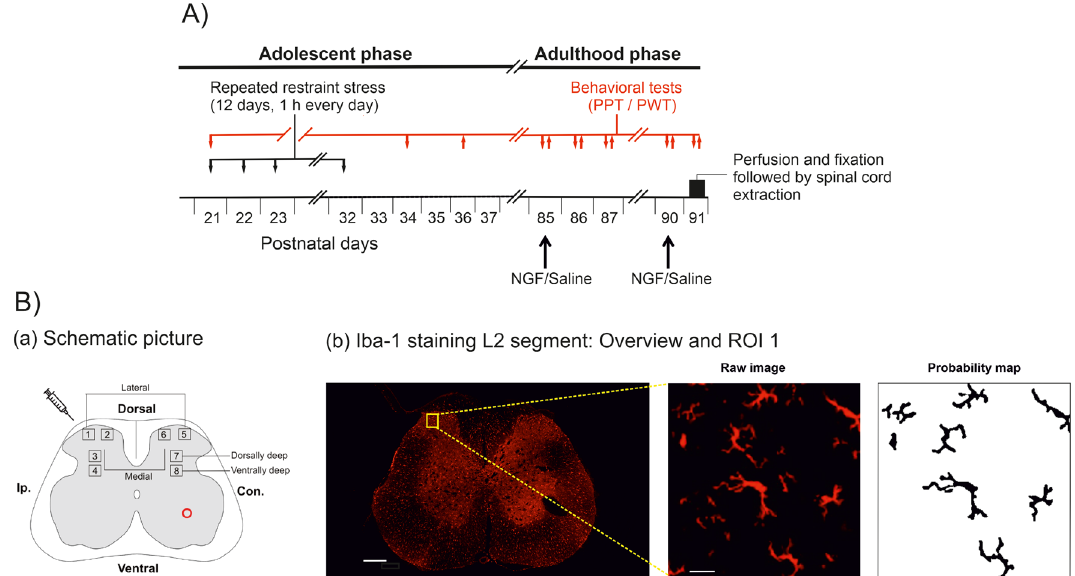
Figure 1. Experimental procedure. ( A ) Animals of the stress group were repeatedly stressed (black line) in a narrow plastic restrainer for 12 consecutive days for 1 h every day on postnatal days (PD21-32; early adolescent phase; black line). The pressure pain threshold (PPT) of the left multifidus muscle at vertebral level L5 and paw withdrawal threshold (PWT) of the left hind paw was measured at different time points (red line) (PPT— downward arrow: PD21, PD34, PD85, PD86, PD87, PD90, PD91; PWT—upward arrow: PD36, PD85, PD86, PD87, PD90, PD91). All animals received injections of NGF/saline on PD85 and PD90 (adulthood phase) according to the group they belonged to (refer to section Treatment groups). On PD91 (black bar) all animals were perfused and fixed. The spinal cord tissues were extracted and stored. ( Ba ) A schematic illustration of the regions of interest on a spinal lumbar 2 (L2) section (refer to section Image processing). The red circle on the ventral horn of the contralateral side denotes the manually made pinhole to identify the contralateral side. ( B.b ) An example overview image (10x) of an Iba-1 stained L2 section (scale bar: 200 µm, background subtracted) and magnified (40x) of ROI 1 (scale bar: 10 µm, Raw image and Probability map). The hole on the ventral horn of the contralateral side denotes the manually made hole with a pin for the identification of contralateral side. PD, postnatal day; Ip., ipsilateral; Con., contralateral; Iba-1, ionized calcium binding adapter molecule 1; ROI, region of